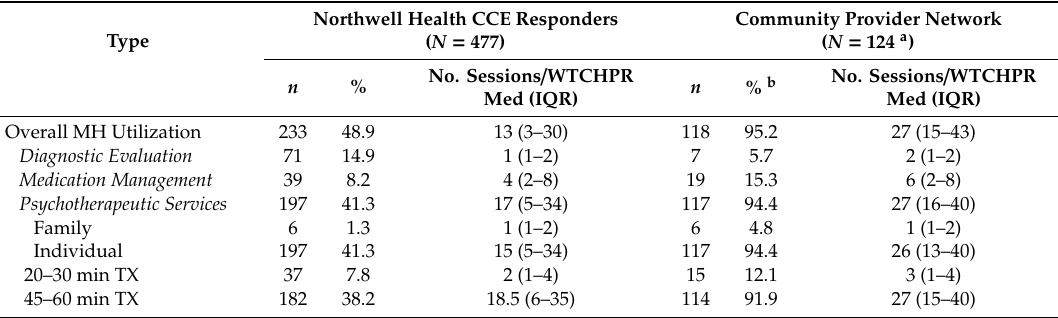
Table 1. Mental healthcare utilization by service type from January 2018–December